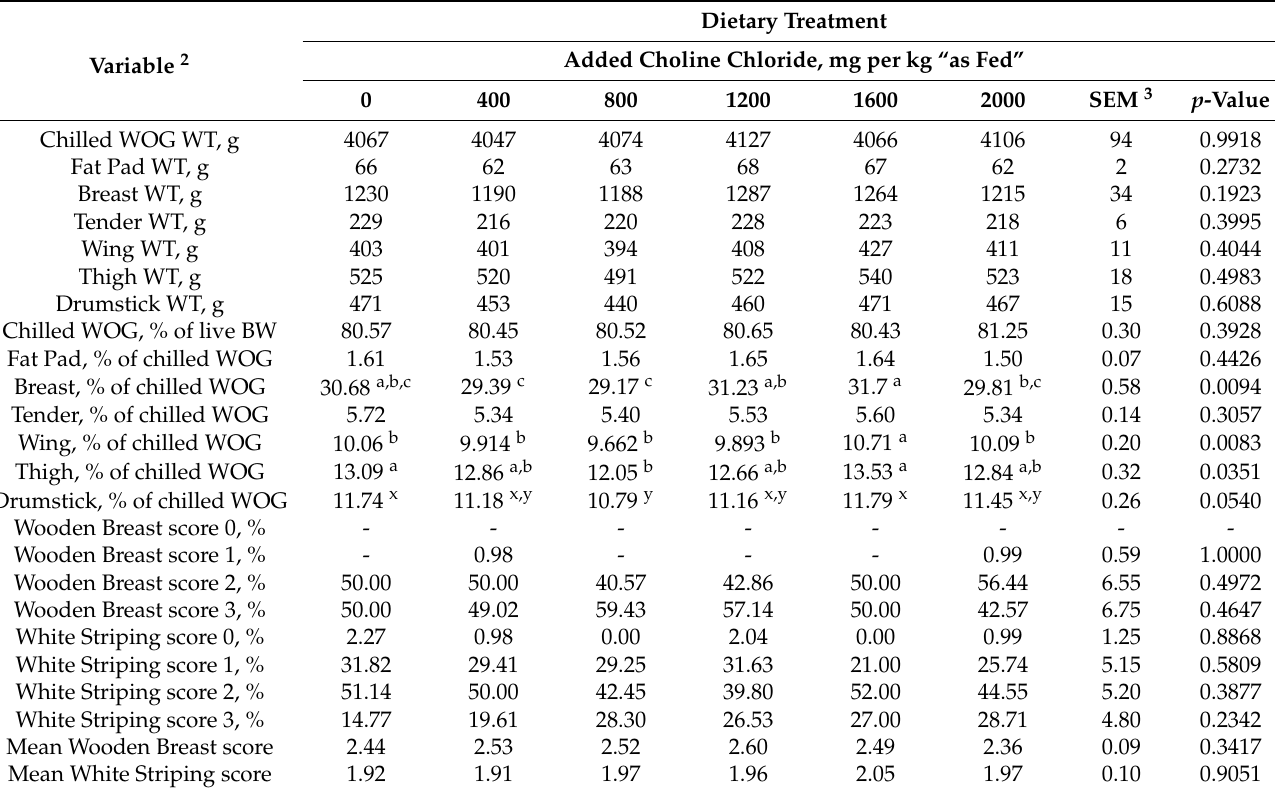
Table 5. Effect of choline chloride supplementation on broiler carcass characteristics at 66 days of age 1